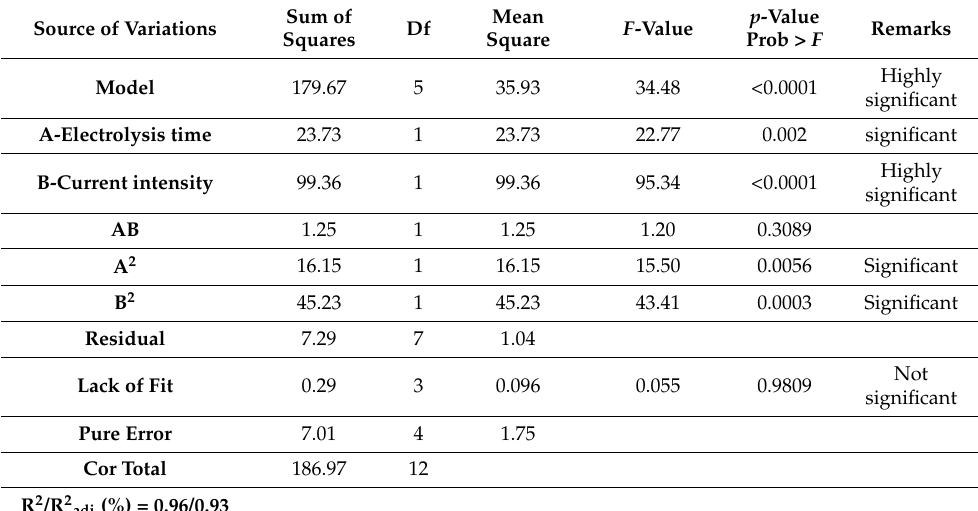
Table 4. ANOVA results of experiment data for Pb